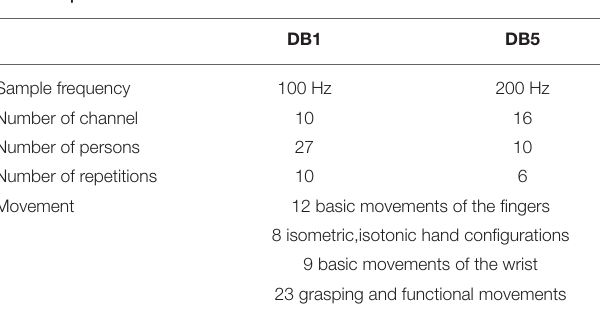
TABLE 1 | Database